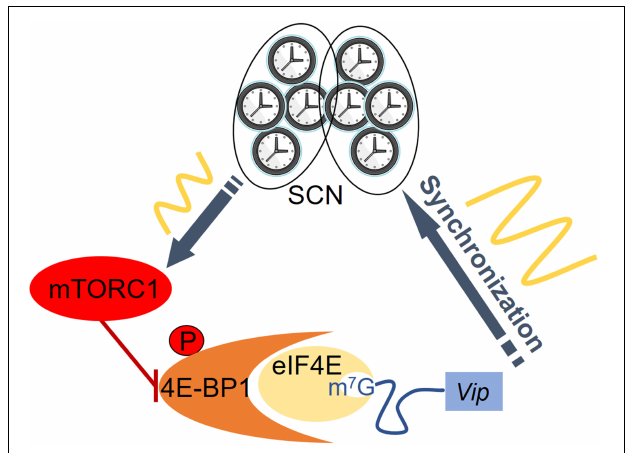
FIGURE 2 | The mTORC1/4E-BP1 pathway regulates SCN cell synchrony via translational control of Vip . Rhythmic mTORC1 signaling phosphorylates 4E-BP1 to promote cap-dependent mRNA translation of Vip and increases the level of VIP in SCN. VIP signaling promotes synchrony of SCN cells and increases the robustness of clock gene oscillation. SCN clock synchrony can be enhanced by removing the translational repressor